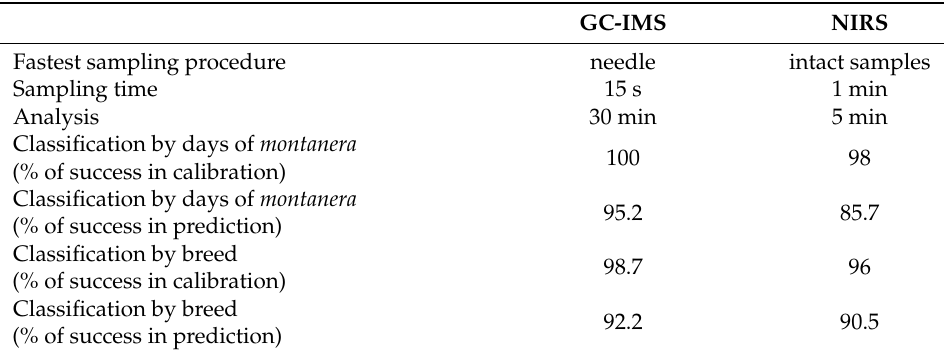
Table 3. Comparison between the Gas Chromatography-Ion Mass Spectrometry (GC-IMS) and Near Infrared Spectrometry (NIRS) classification technologies. GC-IMS